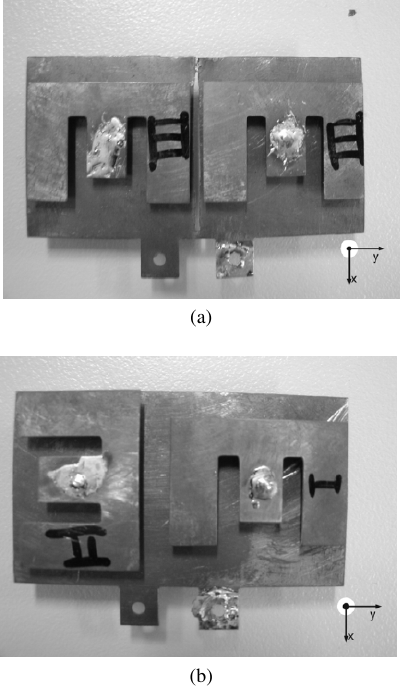
FIGURE 25. E-shaped patch antennas for high speed 5–6 GHz wireless networks. (a) Decoupled antenna array for Tx/Rx duplex. (b) Broadband polarization diversity antenna array. Adapted from